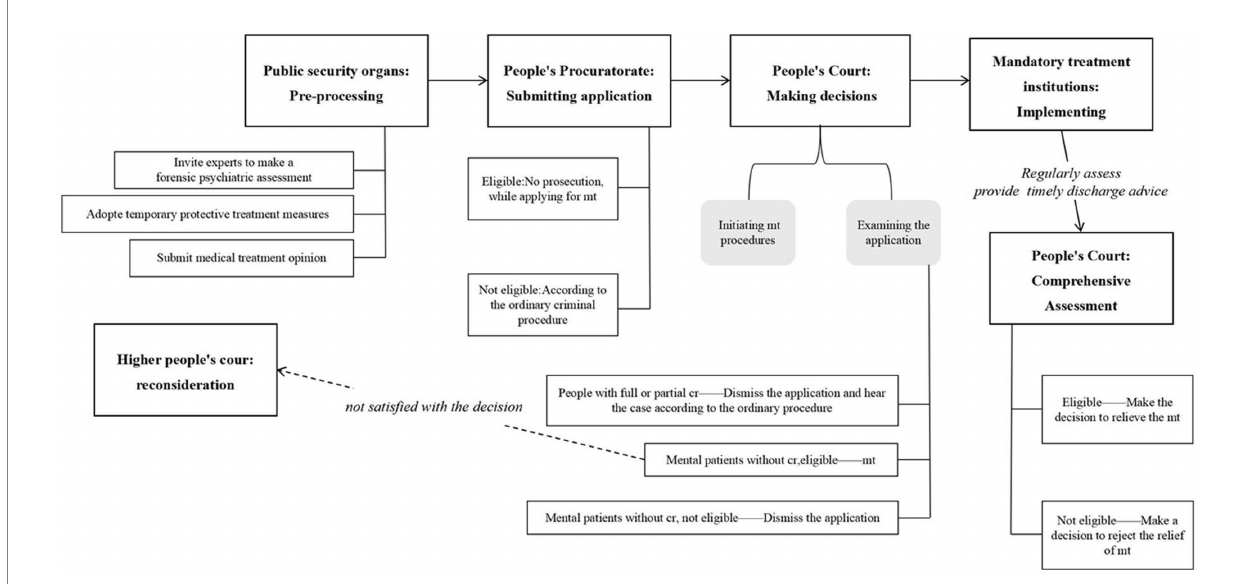
FIGURE 1 Logical structure of mandatory treatment procedures. mt, mandatory treatment; cr, criminal